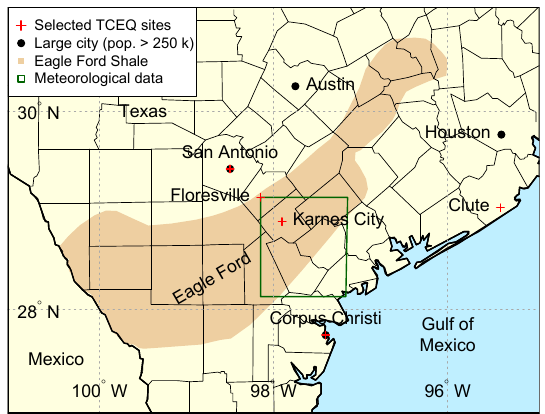
Figure 1. Selected TCEQ NMVOC monitoring sites and large cities near the Eagle Ford. The green box shows the 1 ◦ latitude by 1 ◦ longitude box in which the meteorology was